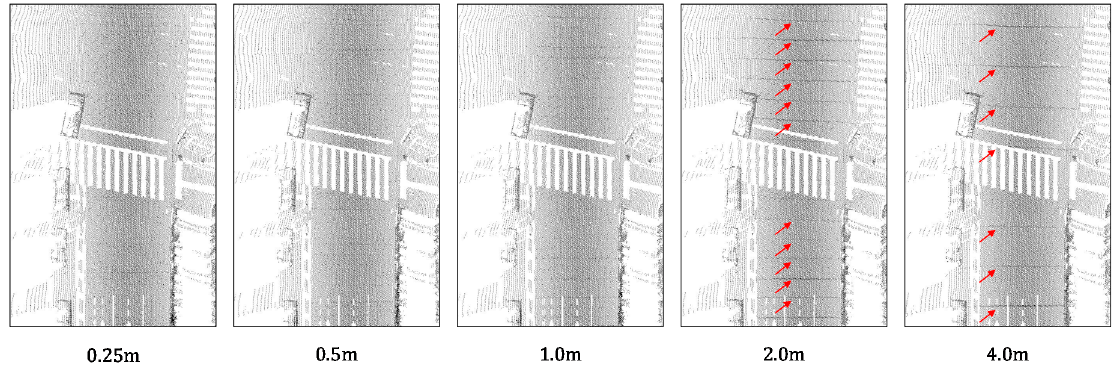
Figure 27. Effect of the patch length on the smoothness of the georeferenced MMS point cloud.